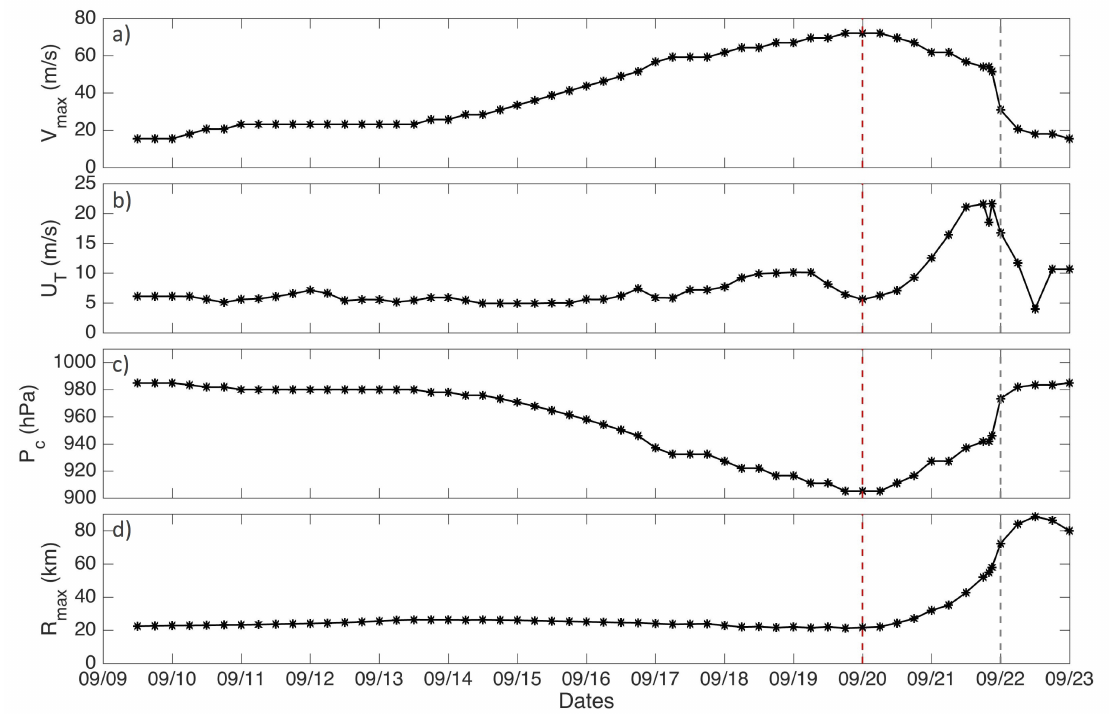
Figure 2. Characteristics of the 1938 New England Hurricane from 9 September 1938 to 23 September 1938. Panels ( a – d ) shows maximum wind speed ( V max ), translation speed ( U T ), central pressure ( P c ) and radius of maximum wind ( R max ), respectively. The latter two quantities are estimated. Red dashed line indicates the time when the hurricane is most intense (indicated by a minimum in central pressure); gray dashed line indicates the time of landfall in Rhode